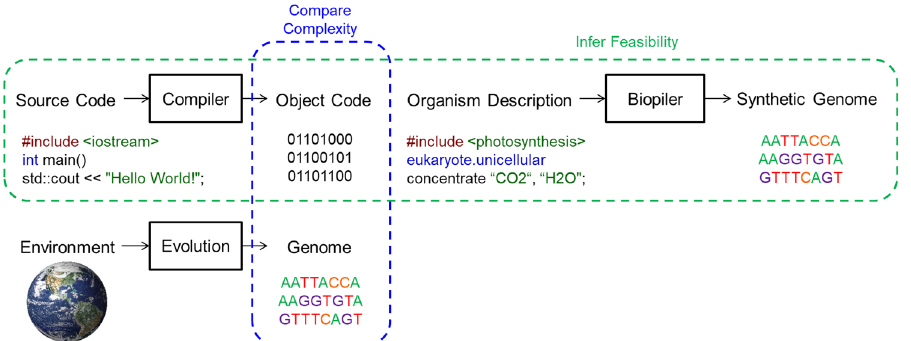
Figure 3. Framework for inferring feasibility of synthetic biology by comparing software object code and organism genome complexity with associated examples or hypothetical implementations. Image of Earth credit: